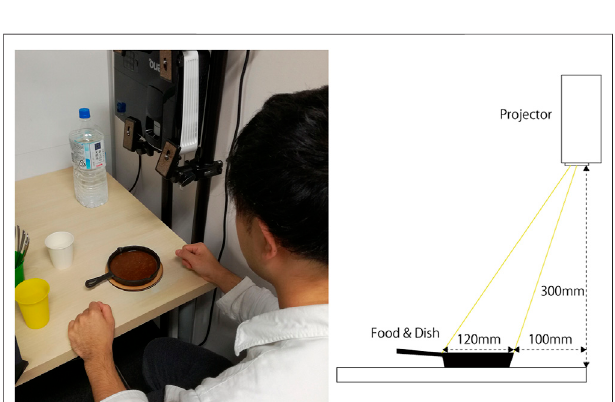
FIGURE 2 | Experimental